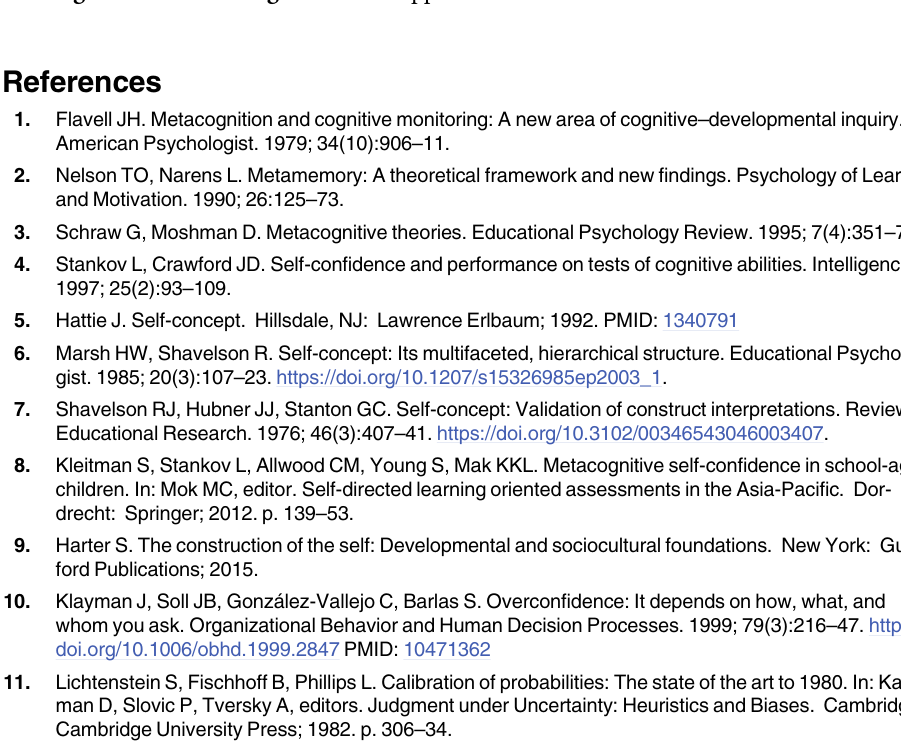
S1 Table. Correlation matrix. S1 Fig. Histograms for self-evaluation